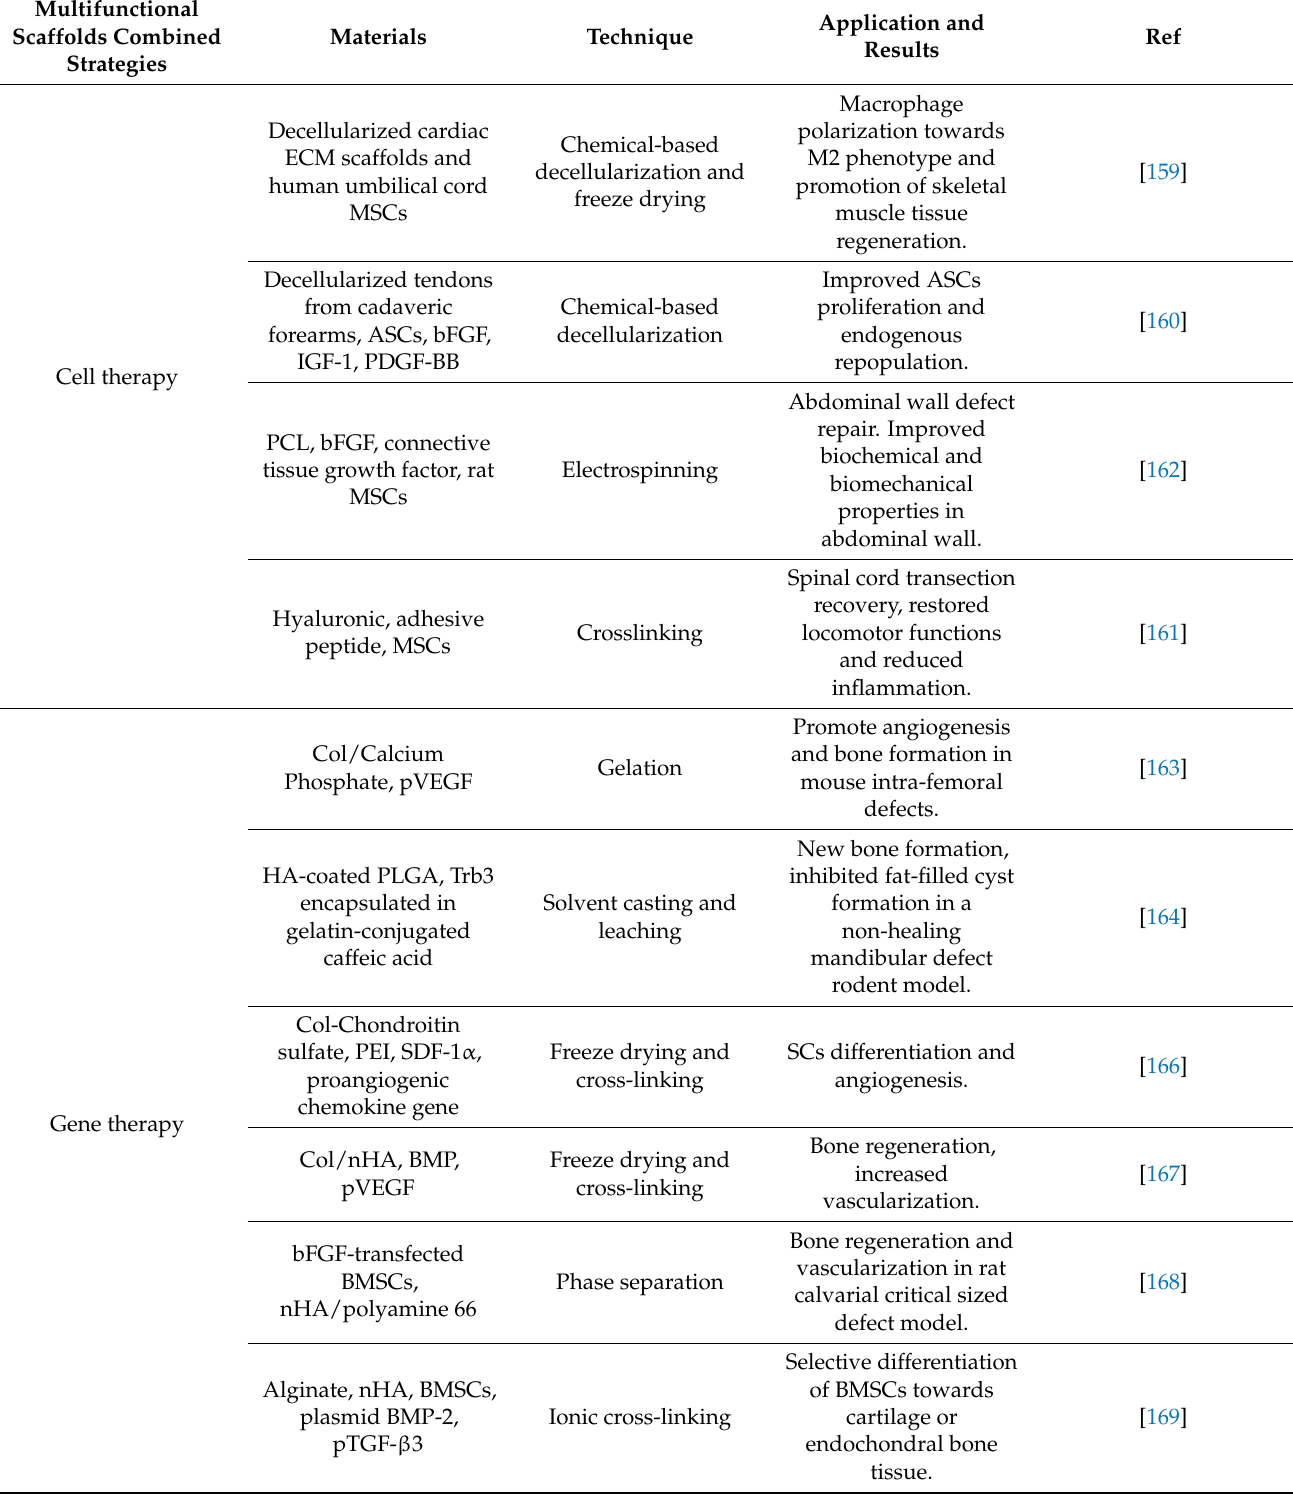
Table A3. Summary of combined multifunctional scaffolds and therapies for tissue engineering reviewed in this article. Multifunctional Scaffolds